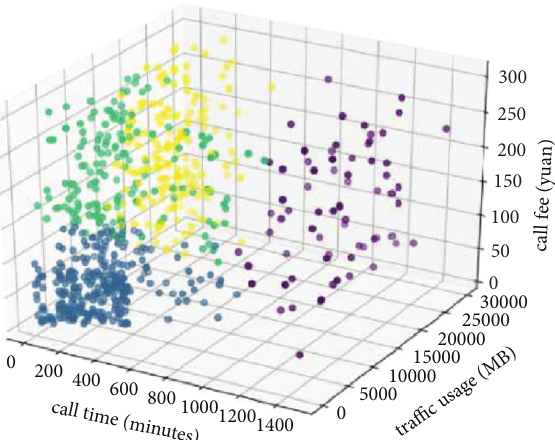
Figure 8: Diagram of